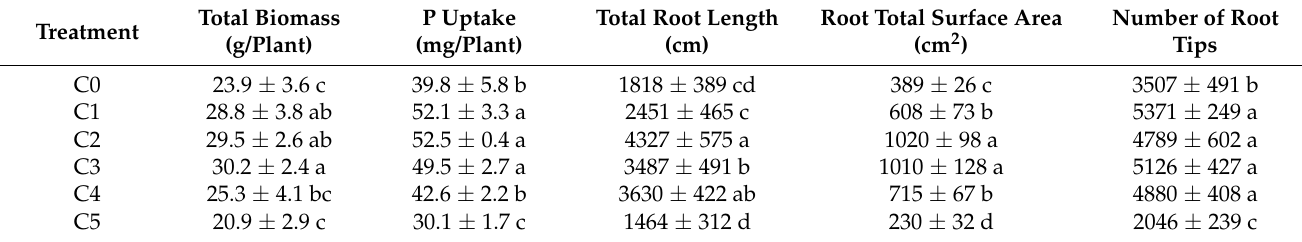
Table 3. Effects of different glucose contents on the growth status of M9T337